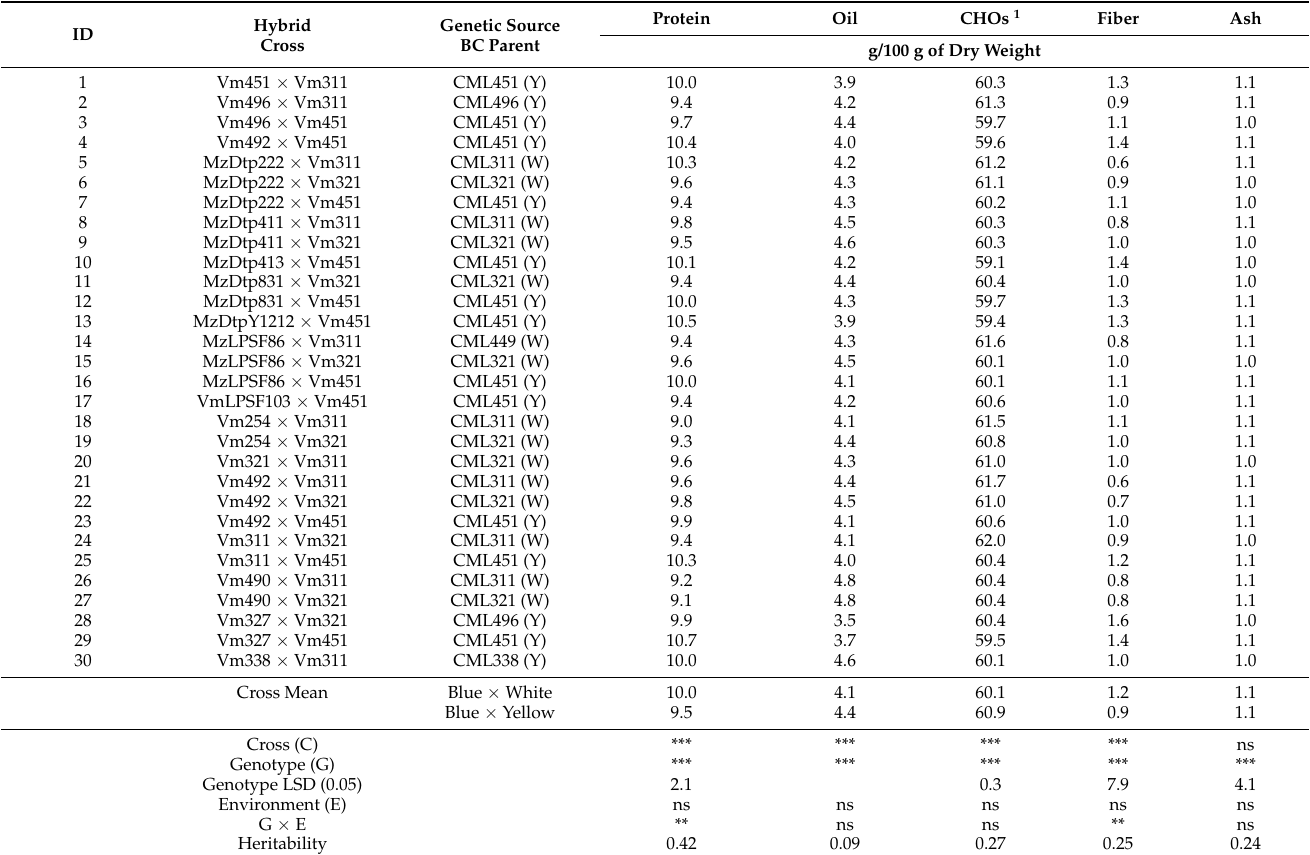
Table 2. Combined analysis of the nutritional composition of kernels from 30 Vitamaiz hybrids grown in two subtropical environments (CEL—Celaya; PV—Puerto Vallarta, Mexico) in